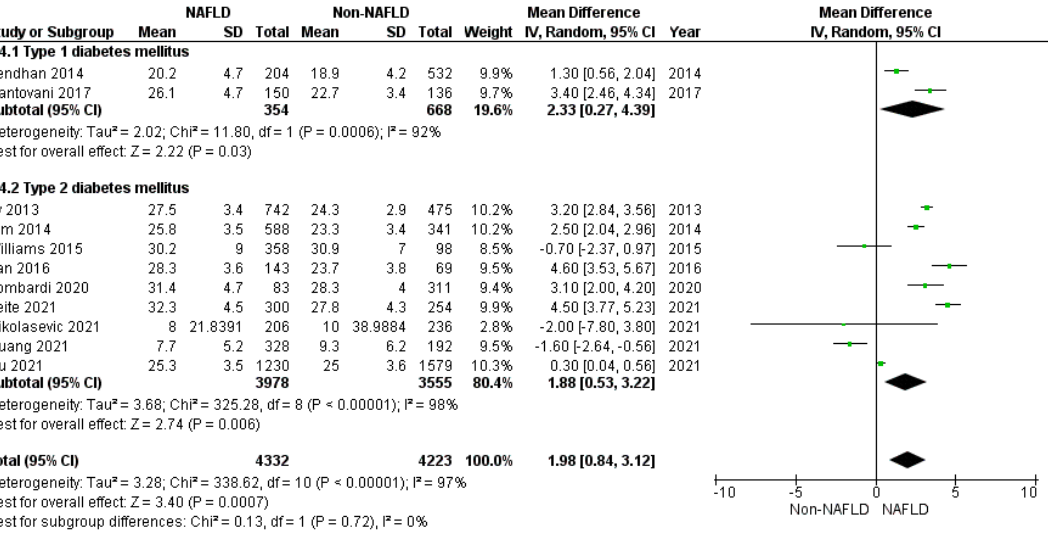
Figure 4. Forrest plot displaying diabetes duration in years, comparing diabetic patients with and without NAFLD. Data are expressed as a mean difference, evaluated by applying the random effect model.